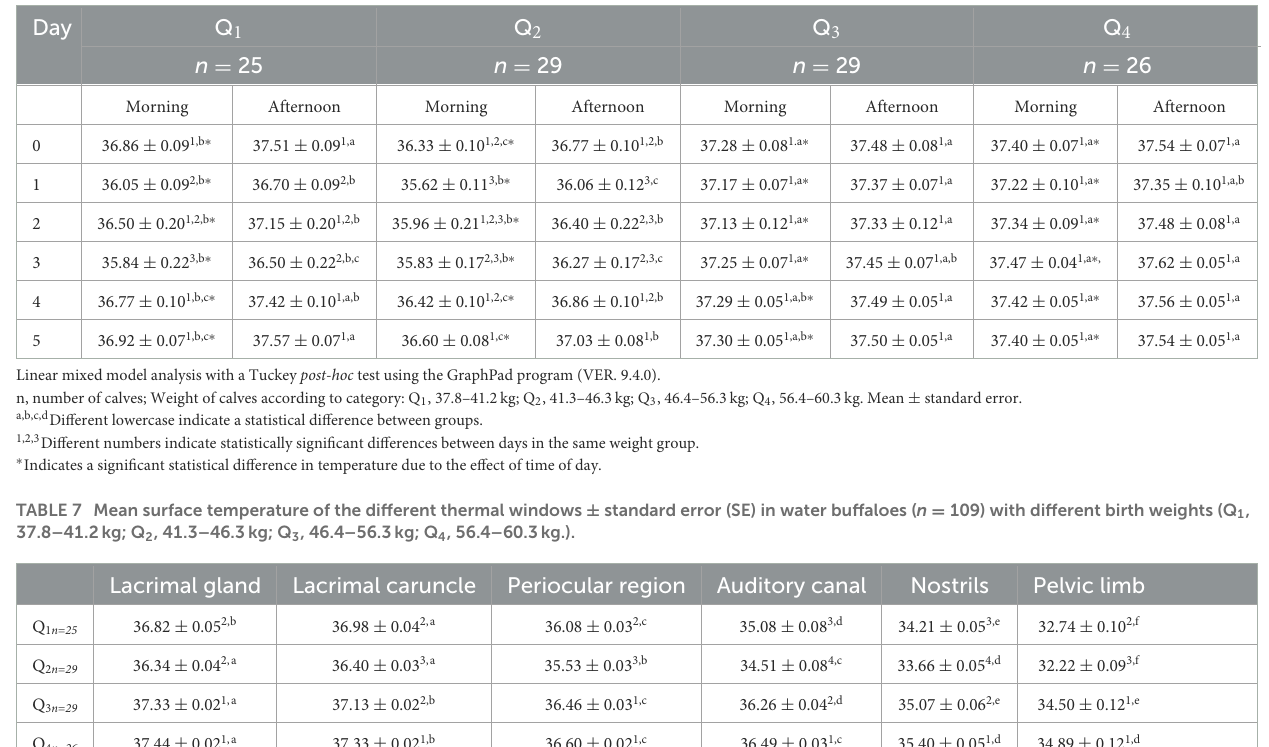
Morning Afternoon Morning Afternoon